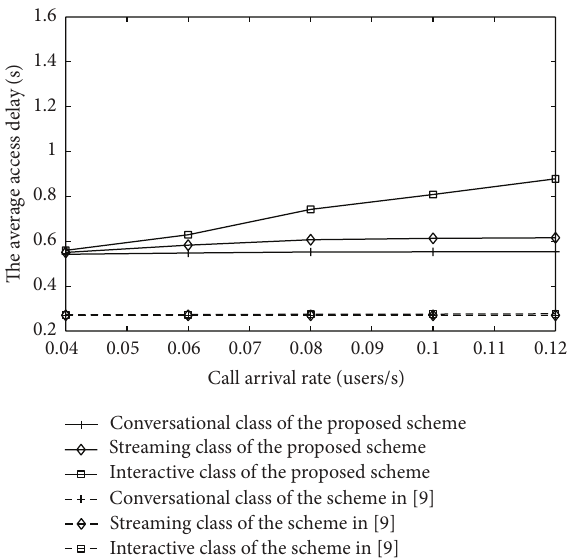
Figure 17: The average end-to-end delay of IDMA